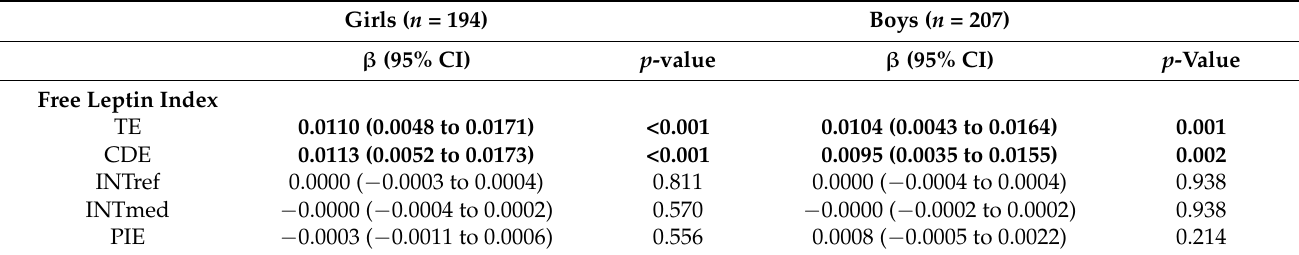
Table 3. Four-way decomposition of the association between MVPA α and TBLH BMC.